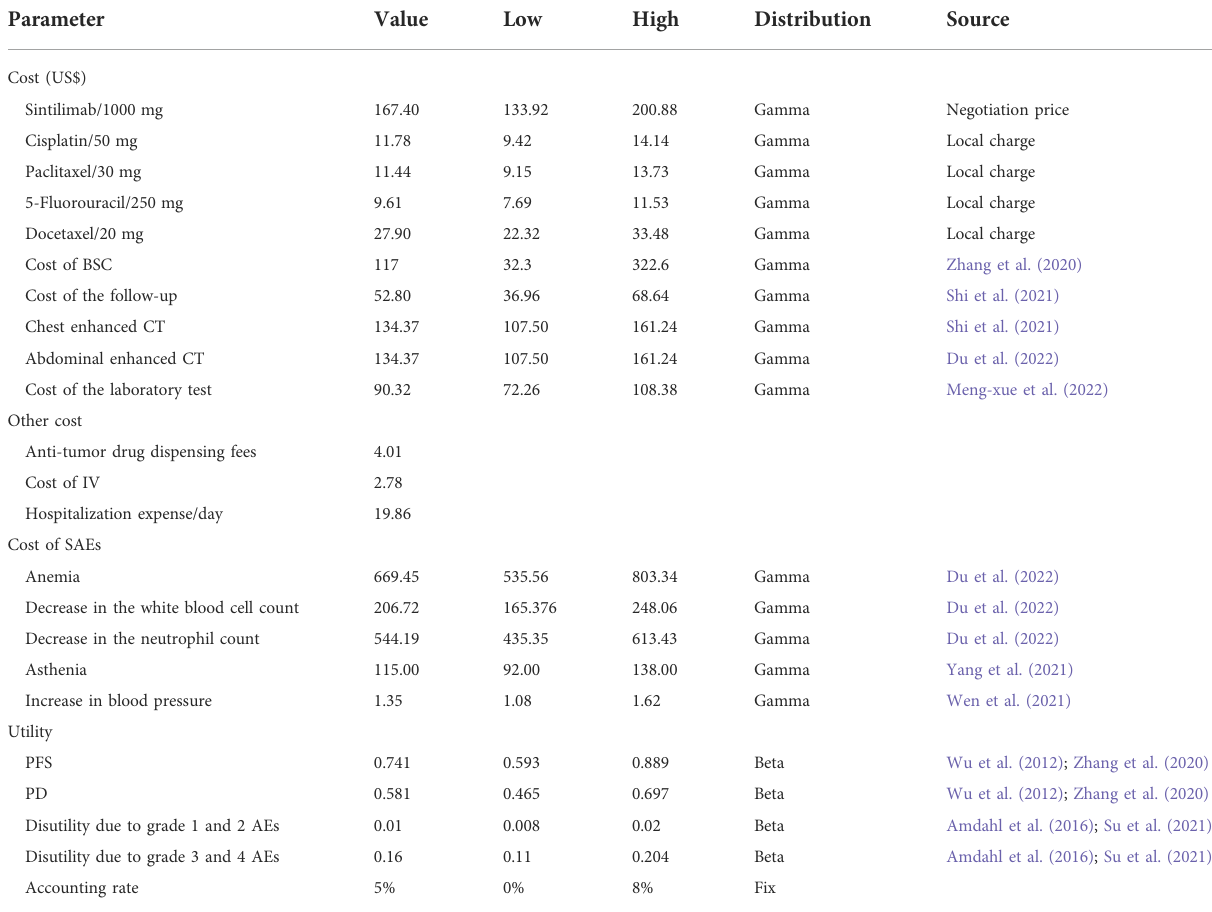
TABLE 4 Key inputs for the cost-effectiveness